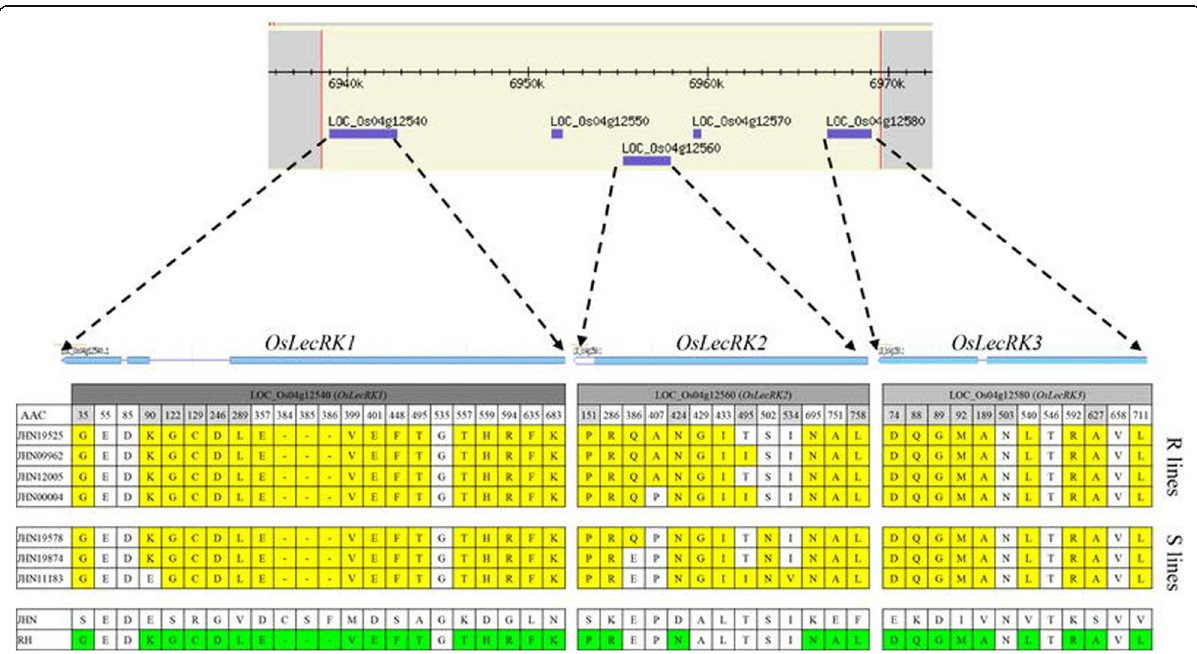
Fig. 3 Amino acids analysis of OsLecRK1 – 3 in JHN WT, mutant lines and BPH-resistant variety Rathu Heenati (RH). Polymorphic sites are positioned relative to the first amino acid in RH. The sequence information for OsLecRK1 – 3 of RH are from the GenBank database (accession no. AIE56222, AIE56230, and AIE56238 respectively). Amino acid changes were highlighted in yellow, and amino acid that JHN WT differed from RH were highlighted in green. The amino acid positions that are corresponding to KASP-SNP markers used for haplotype pattern analysis of mutant lines were highlighted by